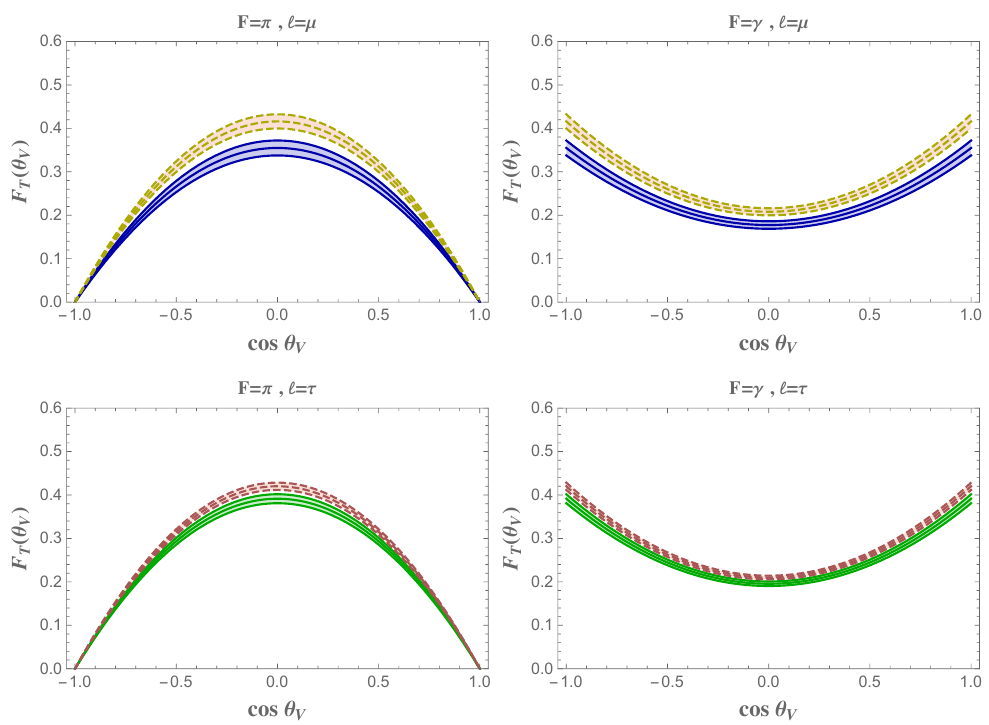
Figure 15 . Distribution F T ( (cid:18) V ). The upper and lower plots refer to the case ‘ = (cid:22) and ‘ = (cid:28) , the left and right column to F = (cid:25) and F = (cid:13) . Color codes as in (cid:12)gure 14.